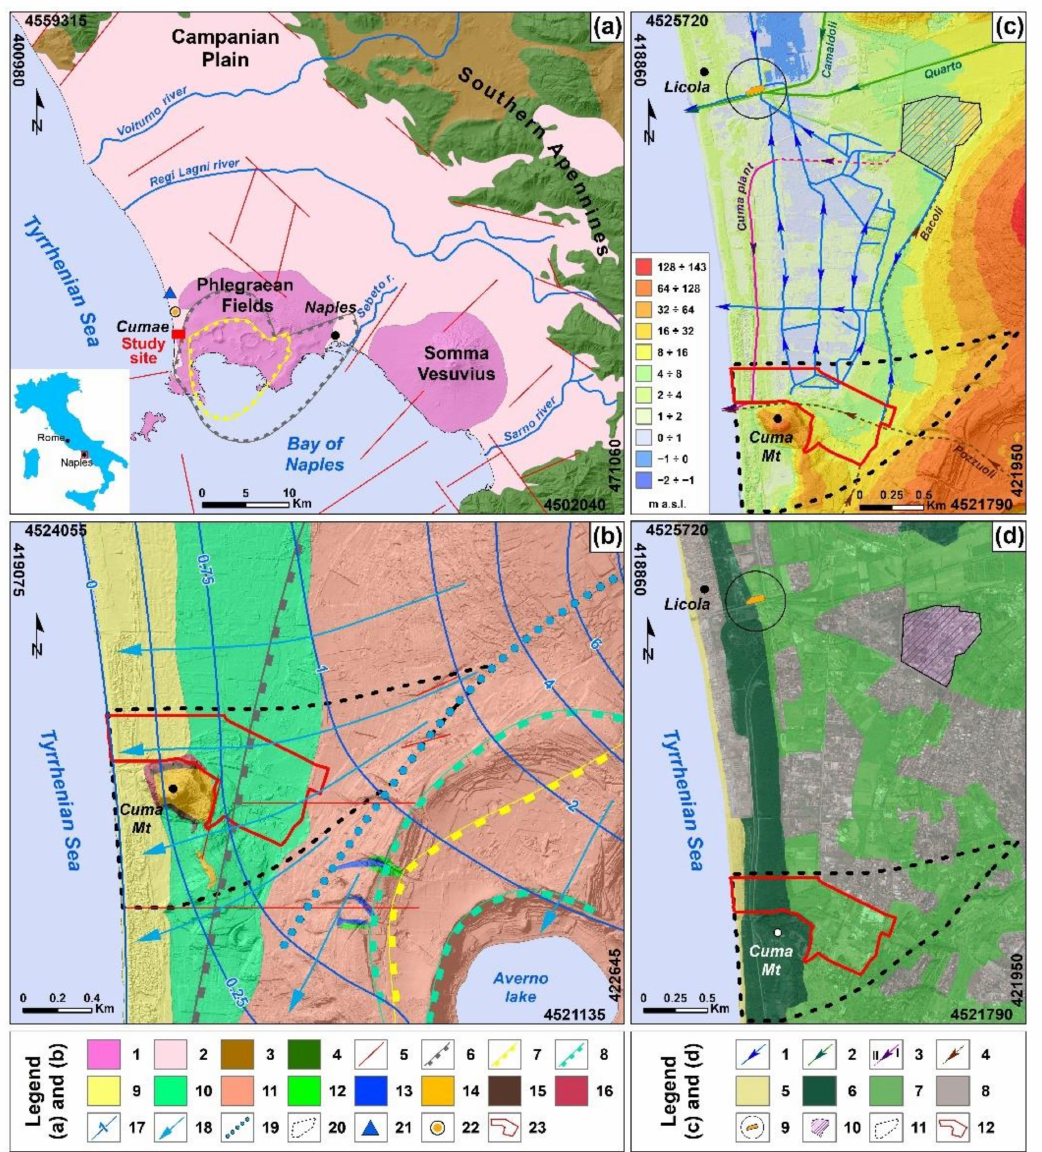
Figure 1. ( a ) Geological map of Campanian Plain and ( b ) hydrogeological map of the eastern sector of Phlegraean Fields (after [61] modified). Legend: (1) Quaternary epiclastic deposits; (2) Quaternary volcanic deposits; (3) Miocene deposits; (4) Mesozoic Apennine platform carbonates; (5) buried fault; (6) Campanian Ignimbrite (CI) caldera boundary; (7) Neapolitan Yellow Tu ff (NYT) caldera boundary; (8) buried caldera boundary; (9) Eolic deposits; (10) Pyroclastic-fluvio-palustrine deposits; (11) Pyroclastic deposits; (12) Baia’s tu ff s; (13) Gauro’s eruption deposits; (14) Neapolitan Yellow Tu ff ; (15) Museum Breccia; (16) Cuma Mt lavas; 17) groundwater contour line (m a.s.l.); (18) groundwater flow direction; (19) groundwater divide; (20) hydrogeological basin of study area; (21) Licola pluviometric station; (22) Licola draining station; (23) study area. ( c ) Geomorphological setting, hydrographic network and ( d ) land use of the hydrographic and hydrogeological basin of study area. (1) Reclamation draining channel; (2) surface water channel; (3) open-air (i) and underground (ii) Cuma wastewater treatment plant discharge channel; (4) underground wastewater channel; (5) beach; (6) Mediterranean bush and pinewood; (7) agricultural land; (8) urban area; (9) Licola drainage station; (10) Cuma wastewater treatment plant; (11) hydrogeological basin of study area; (12) study